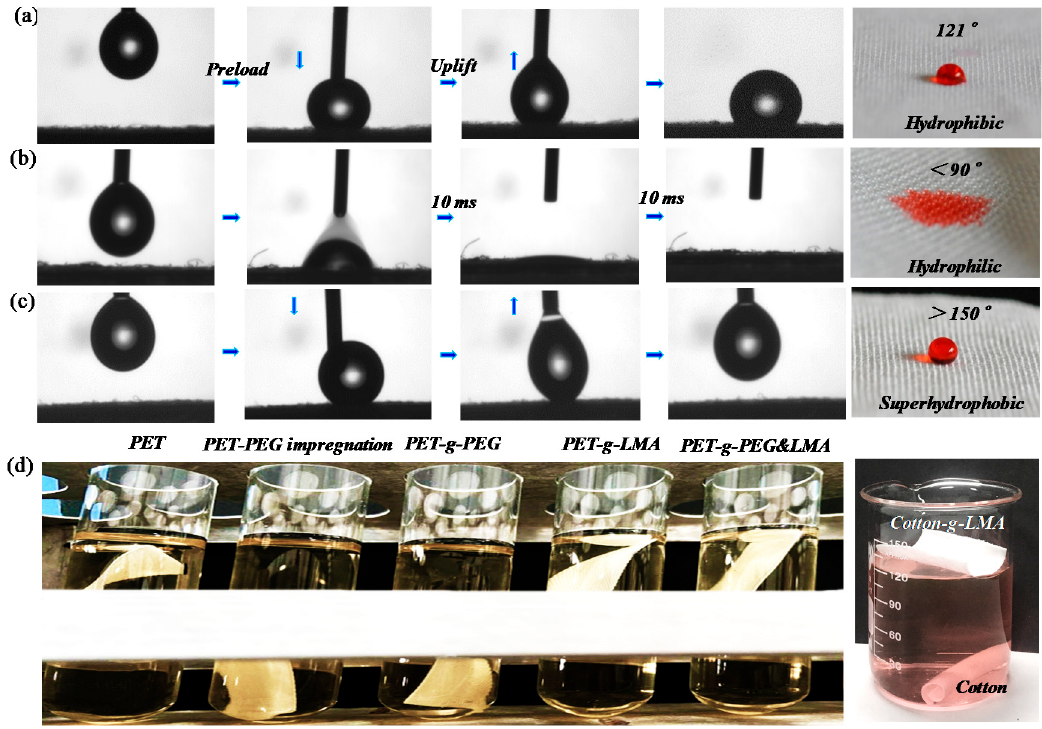
Figure 3. The contact states of water droplets with different PET fabric surfaces: ( a ) PET, ( b ) PET-g-PEG (or cotton), ( c ) PET-g-PEG&LMA (or PET-g-LMA or cotton- g -LMA) and ( d ) the state of different fabrics in water.